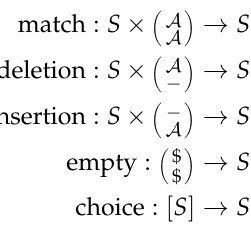
Figure 2. Signature for the problem of string alignment. The signature lists the situations that need to be evaluated differently by specifying the input and output for each situation. Here, S is the score, A a letter from the alphabet, − the none symbol and $ the empty